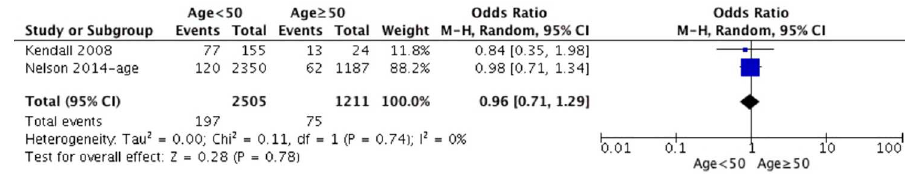
Fig 4. Correlations between age and complications.